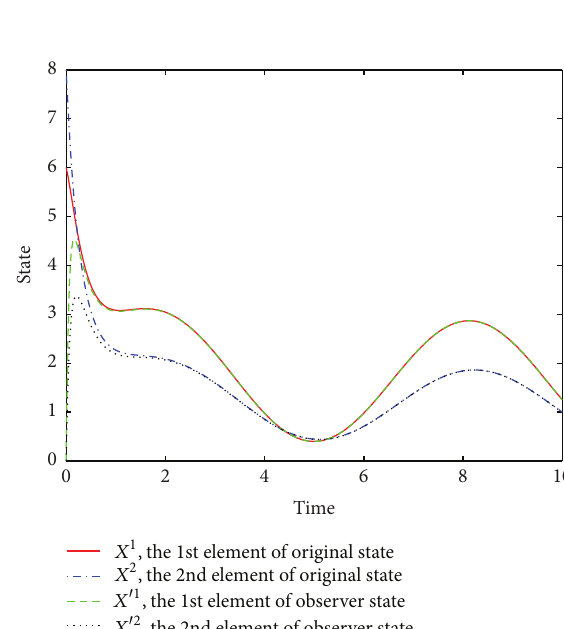
Figure 1: The figure of switching law.